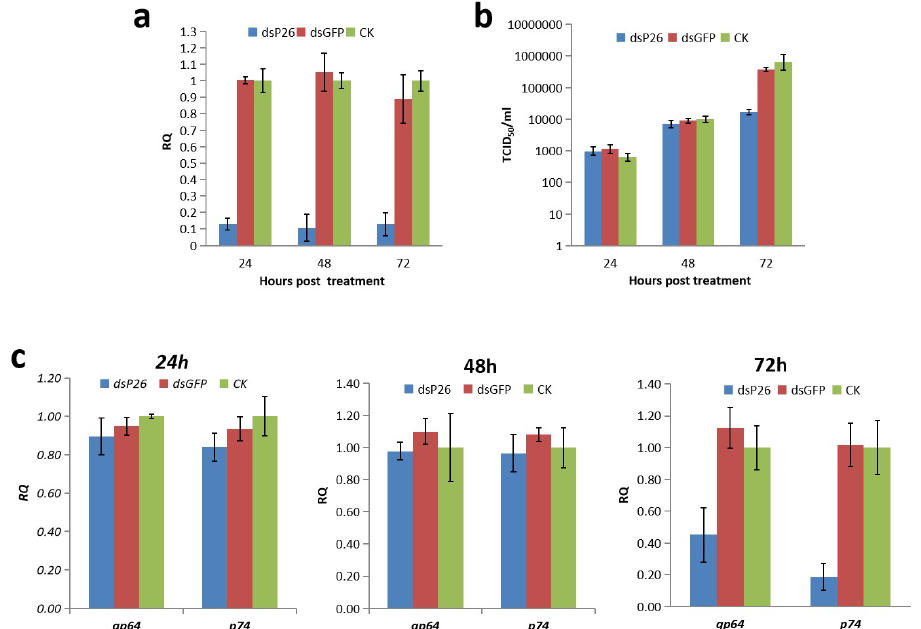
Figure 4. p26 knockdown by RNAi and its influence on viral replication. BmN cells were infected with BmNPV. At 3 hpi, the cells were transfected with dsP26 and dsGFP, and non-dsRNA-treated BmN cells (CK) were used as the control. ( a ) Q-PCR analysis of p26 knockdown in BmNPV-infected BmN cells. Total RNA was extracted from BmNPV-infected BmN cells at 24, 48, and 72 h post-dsRNA treatment, reverse transcription and Q-PCR were performed, and the relative p26 transcript levels were analyzed using the △△ Ct method. The derived relative quantity (RQ) values were normalized to those of non-dsRNA-treated controls, and ie1 transcript detection was included as the internal control. Data are presented as the mean RQs ± SEMs for three replicates. ( b ) Titration of BV from BmNPV-infected BmN cells in which p26 was knocked down by using dsRNA. At 24, 48, and 72 h post-dsRNA treatment, the supernatants of BmNPV-infected BmN cells were collected for titration by using the TCID 50 /mL method. Data are presented as the mean RQs ± SEMs for three replicates. ( c ) Q-PCR analysis of gp64 and p74 transcripts in BmNPV-infected cells with p26 knockdown. gapdh detection was included as internal controls. Data are presented as the mean RQs ± SEMs for three replicates.